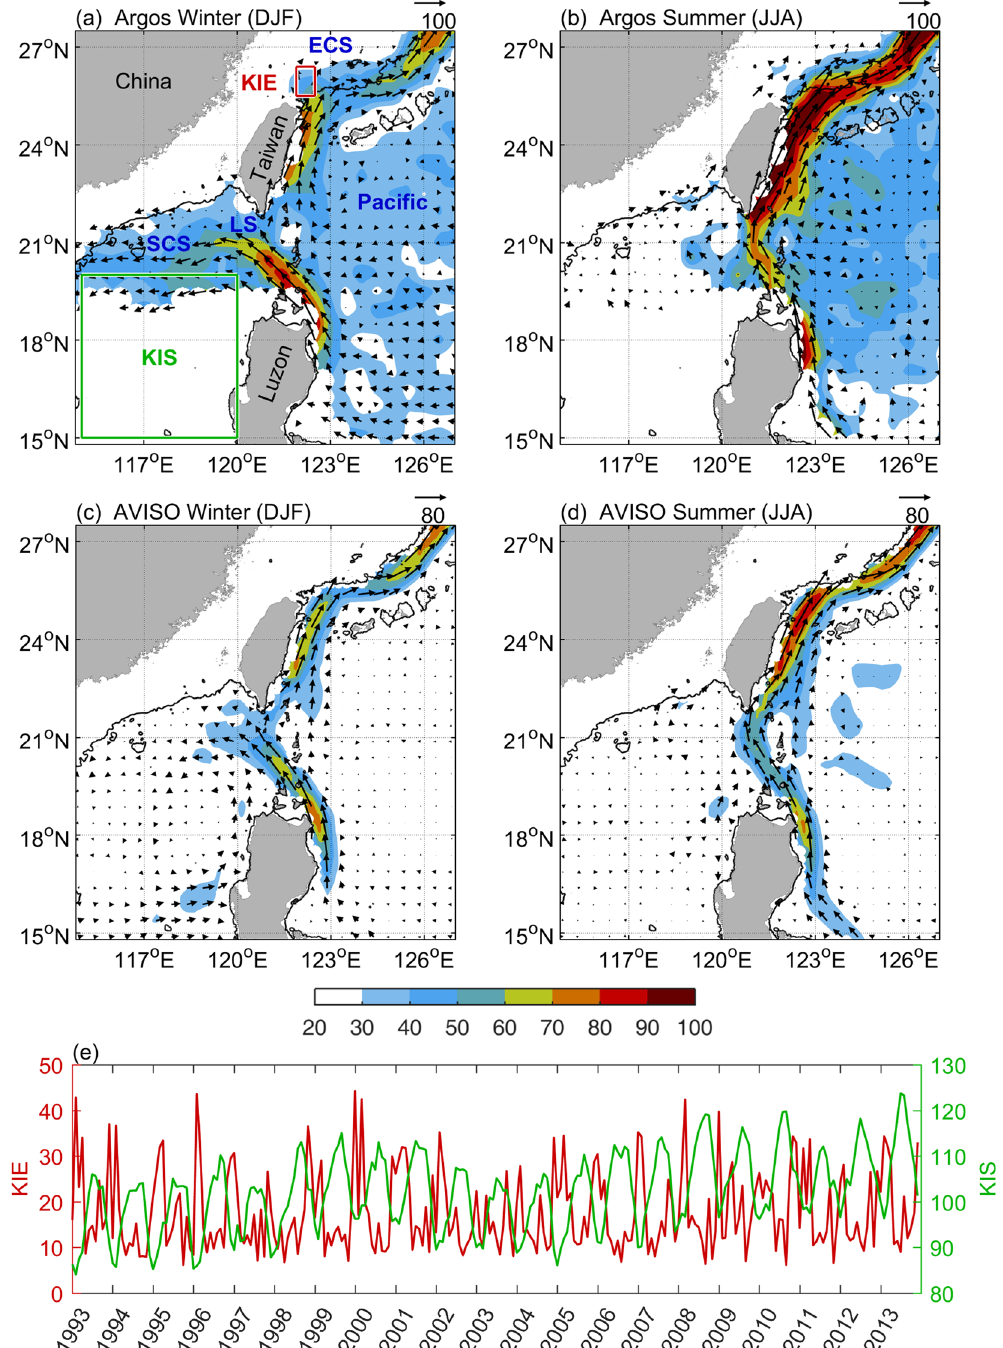
Figure 1. Seasonal Kuroshio intrusions into China Seas averaged over 1993–2013. ( a ) Wintertime (Dec-Jan- Feb) surface currents (vector and shading, in units of cm s − 1 ), obtained from Argos measurements (15 m depth). The 200 m isobath (black contour), Luzon Strait (LS), East China Sea (ECS), and South China Sea (SCS) are marked. Boxes KIE and KIS in red and green, respectively are used to index Kuroshio intrusions. Meshes with available gridded data less than 24 months are ignored. ( b ) Same as Fig. 1a, except during summertime (Jun- Jul-Aug). ( c , d ) Same as Fig. 1a and b, but for surface geostrophic current derived from AVISO. ( e ) Time series of KIE and KIS index, in units of cm s − 1 and cm, respectively. All figures are generated with MATLAB (R2017a;